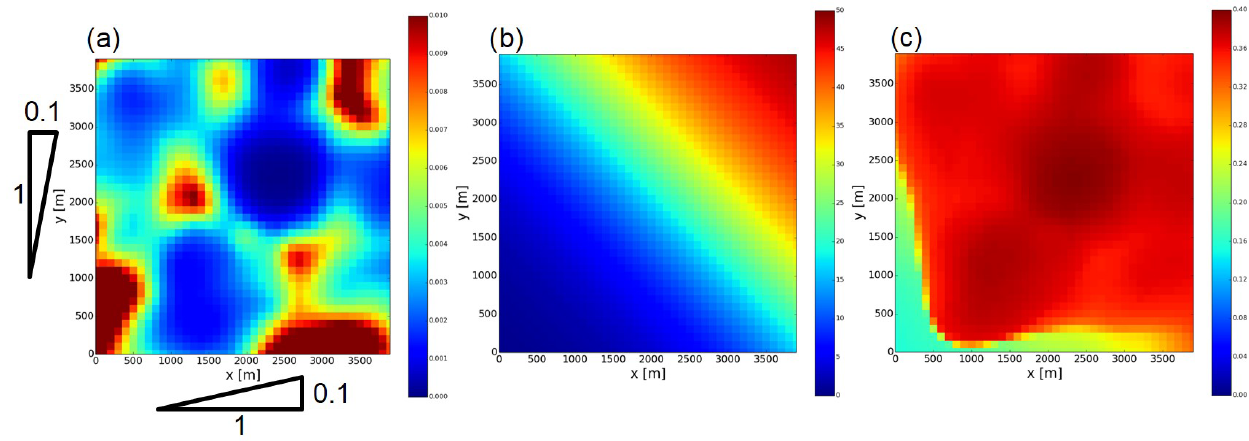
Figure 6. (a) Distribution of surface-saturated hydraulic conductivity (mh − 1 ) in the synthetic reference. (b) Distribution of rainfall rate (mmh − 1 ) in the synthetic reference. (c) Surface volumetric soil moisture (m 3 m − 3 ) at t = 5 (h) in the synthetic reference.